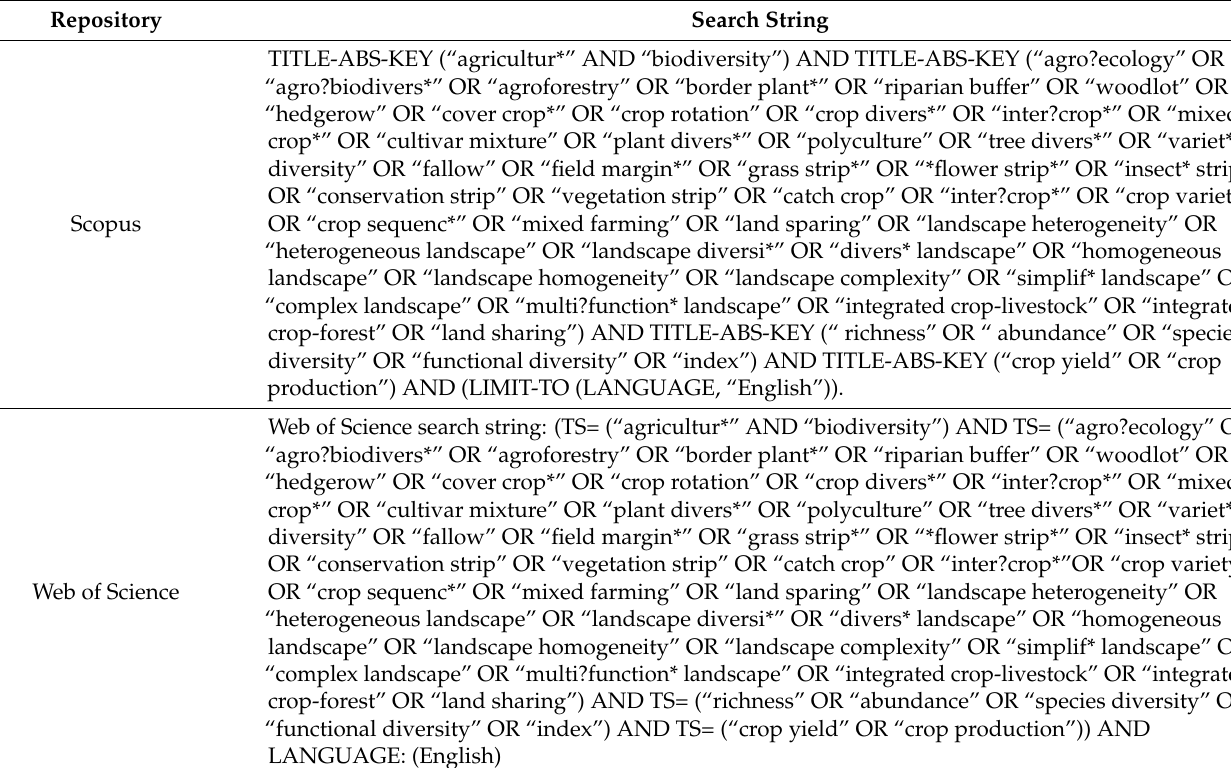
Table 1. Search strings that will be used to identify relevant articles in two global repositories. The wildcard “*” is used to represent unknown characters or no character, and “?” to represent a single character or no character, to allow for variable spellings and truncations of search terms. Repository Search String